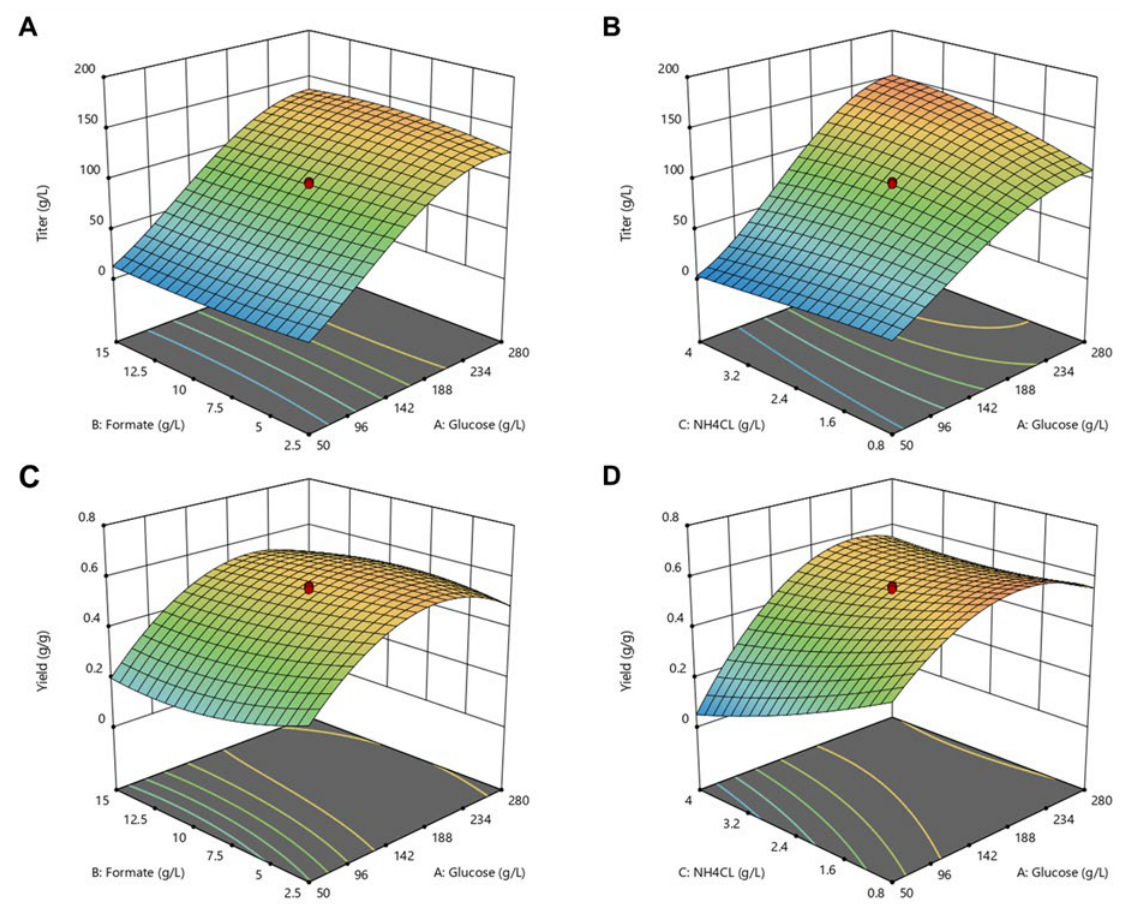
Figure 5. D-surface diagrams of the effect of glucose, formate and ammonium chloride on itaconate production. ( A , B ): itaconate titer, ( C , D ): itaconate yield; ( B , D ) at a sodium formate concentration of 8.8 g L − 1 , ( A , C ) at an ammonium chloride concentration of 2.4 g L − 1 . Red dots represent the design points of the model (filled above predicted value, transparent below predicted value). Models were established for U. cynodontis ∆ fuz7 ∆ cyp3 P etef mttA ↑ P ria1 . Color of the diagrams indicate predicted itaconate titer ( g L − 1 itaconate) and yield ( g g − 1 ).